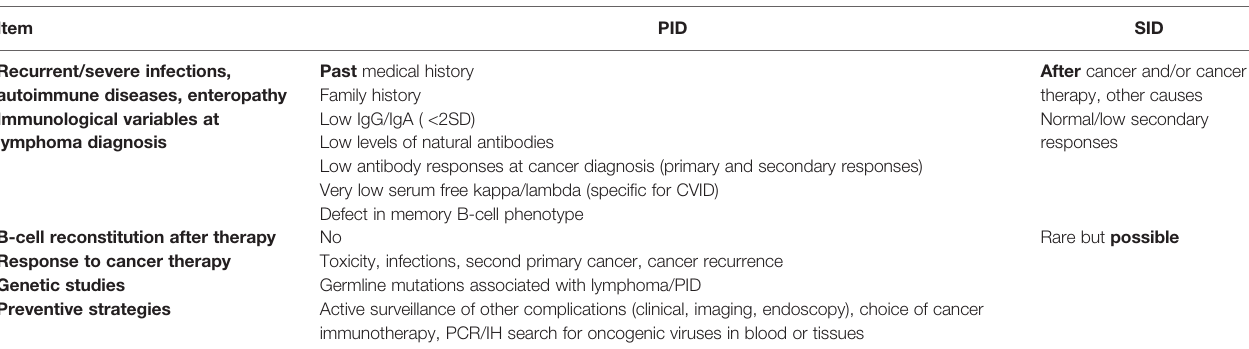
TABLE 2 | Variables that can help differentiate between PID and SID in patients with hematological malignancy. Item SID